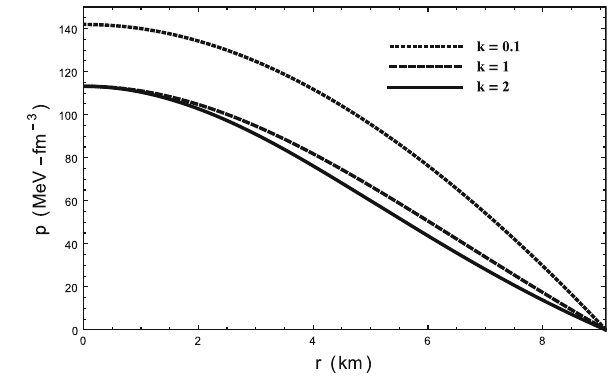
Fig. 2 Radial dependance of pressure p